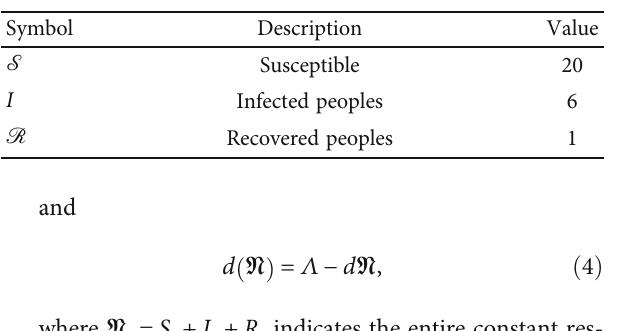
Table 2: Compartments and